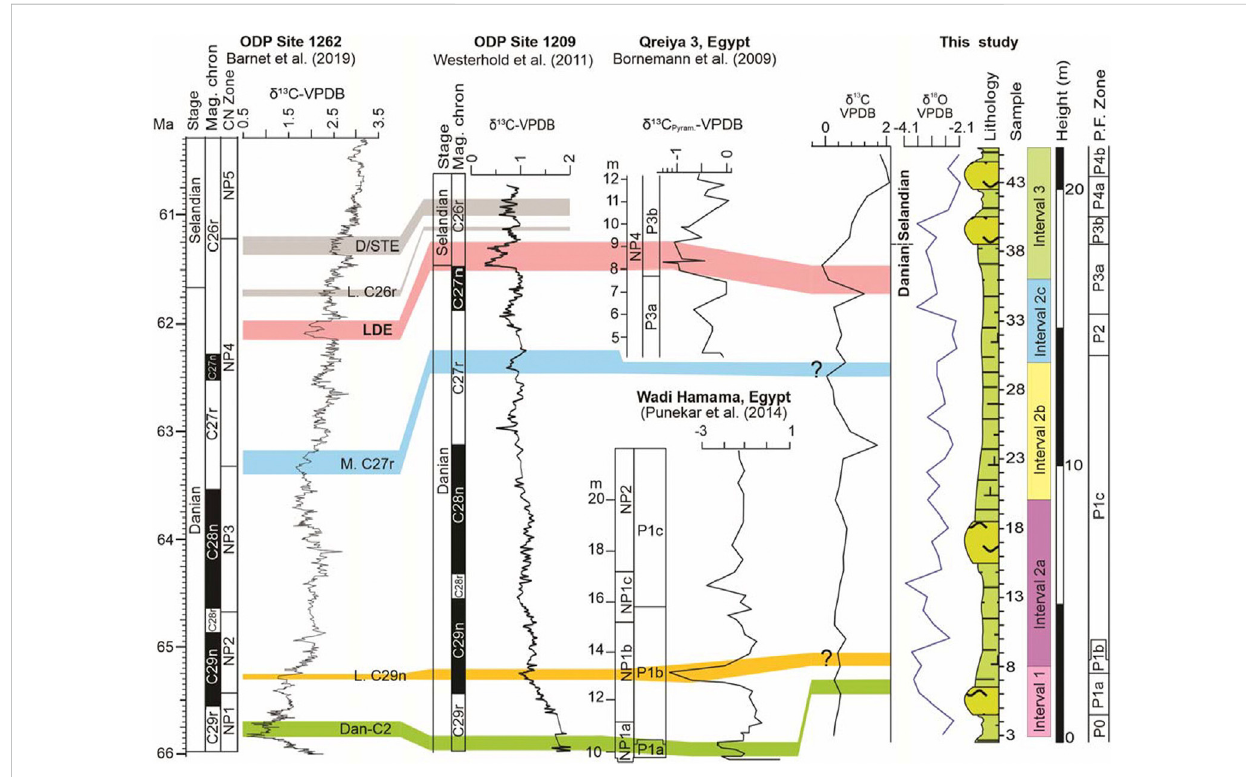
FIGURE 4 Correlationof δ 13 CisotopecurvesofODP(OceanDrillingProgram)sites1262and1269,QreiyaandWadiHamamasections(Egypt)andtheThemed section (present